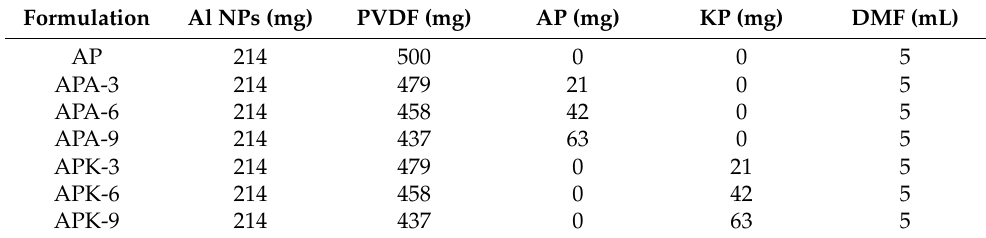
Table 2. Chemical